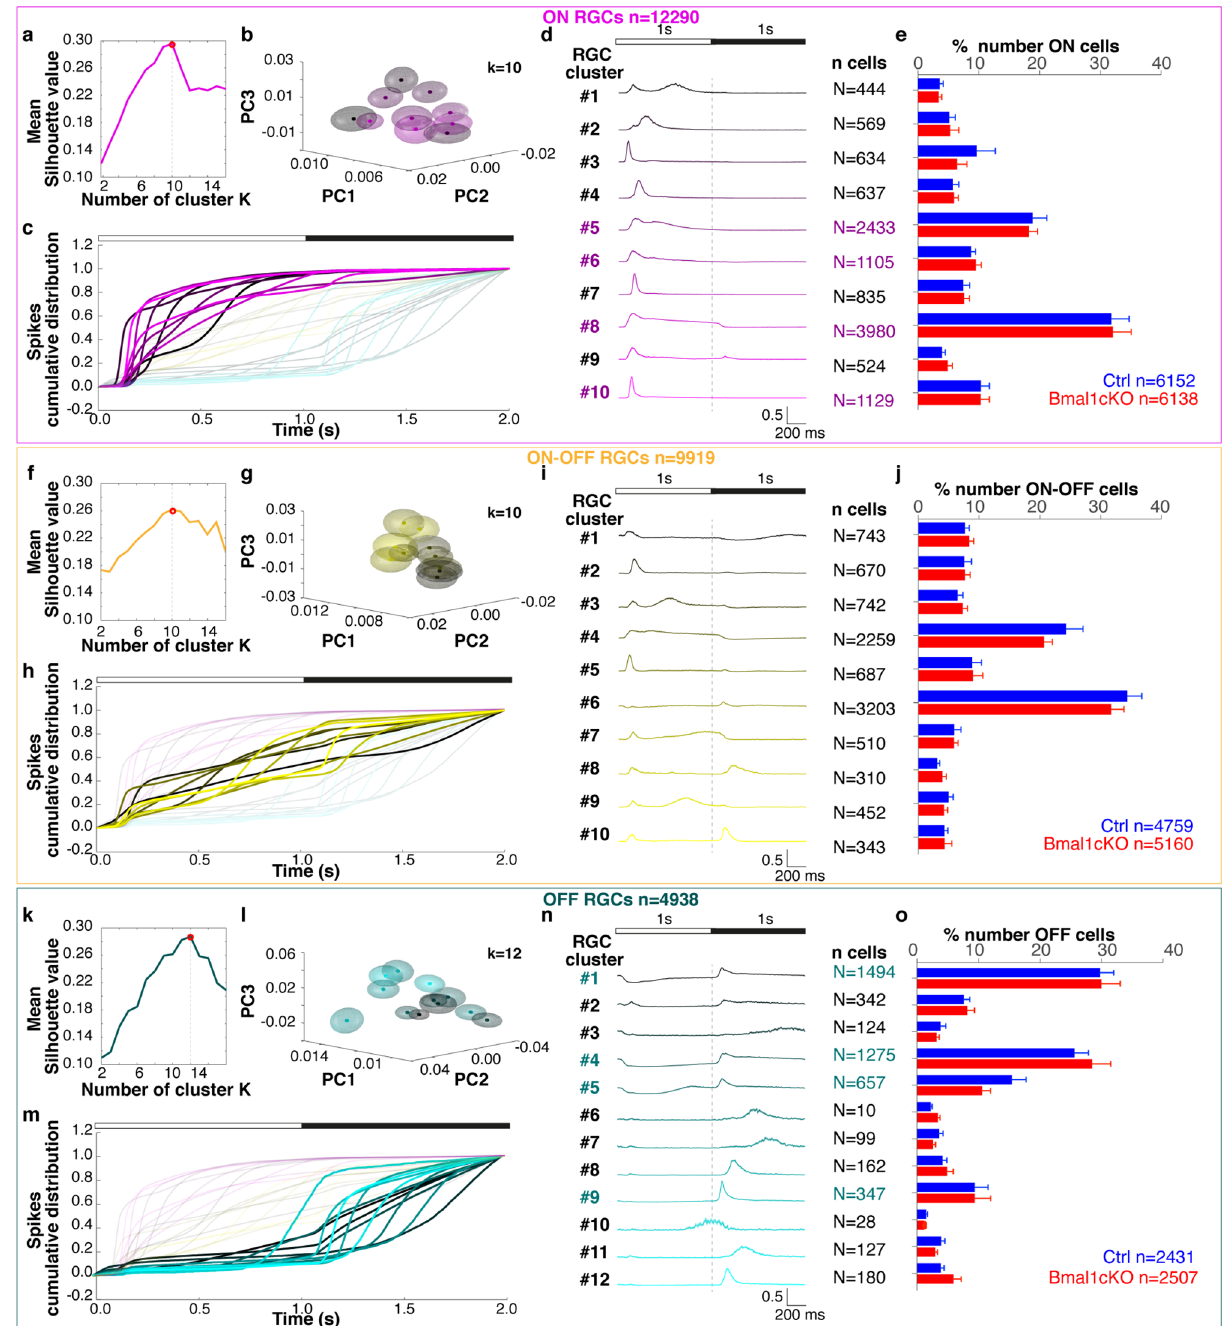
Figure 4. Functional characterization of ON, ON–OFF and OFF type RGCs detected from responses to full- field flashes in Ctrl and Bmal1 cKO retinae under mesopic conditions. (a–f–k) The mean Silhouette analysis (average silhouette values 0.30, 0.26, and 0.28 for ON, ON–OFF, and OFF RGCs, respectively) suggests an optimal number of 10 clusters for ON and ON–OFF RGCs, and 12 for OFF RGCs. “k” represents the number of clusters that maximize the silhouette width. (b–g–l) Principal component analysis (PCA) of ON, ON–OFF, and OFF RGCs. (c-h-m) Cumulative spike trains distribution to alternating 1 s white and 1 s black flashes (20 repetitions, CT100) for ON, ON–OFF, and OFF RGCs. Each line represents the averaged response of the cells belonging to the color-coded cluster. (d–i–n) Population response for ON, ON–OFF, and OFF cells (10 ON, 10 ON–OFF, and 12 OFF clusters) per cluster. Each row shows the normalized PSTH of a single cluster. The numbers on the right of the PSTHs represent the numerosity of each cluster. (e–j–o) The histograms denote the relative proportion of recorded RGCs from each retina (Ctrl in blue and Bmal1 cKO in red) assigned to the cluster. Cluster numerosity does not exhibit bias toward one of the two strains (Multiple t -tests correct). Data are shown as mean ± SEM. On the bottom right of each panel, the total amount of ON, ON–OFF, and OFF RGCs recorded in Ctrl and Bmal1 cKO. Clusters ON 5, 8, 6, 10 and clusters OFF 1, 4, 5, and 9 represent the most abundant and further analyzed